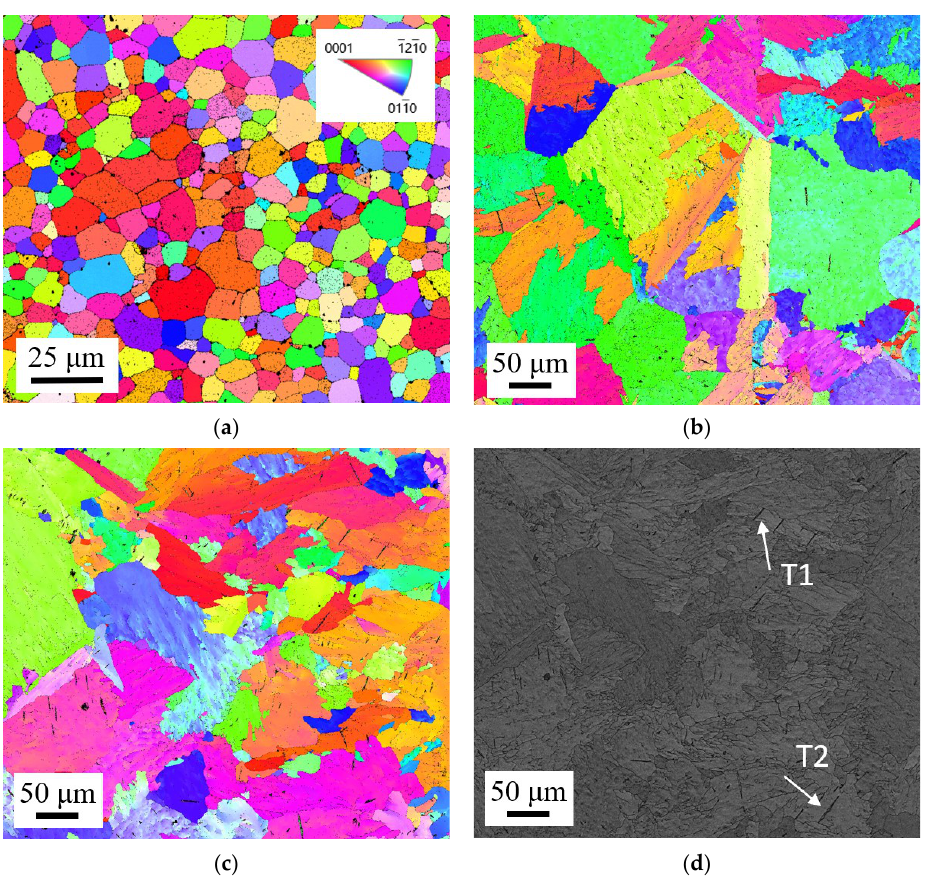
Figure 9. EBSD analysis of material specimens extracted from LMD tailored material: ( a ) IPF map for A-R specimen with no LMD thickening ( b ) IPF map of 0.3 mm LMD layer; ( c ) IPF map of 0.9 mm LMD layer; ( d ) Band contrast image of 0.9 mm LMD layer showing twinning. A high magnification coloured IPF map was performed to examine the microstructure of the LMD part in greater detail, Figure 10a. The map contains several single grains and a fragmented large grain with intragranular misorientations. The single grains are presumed to be the microstructure of the melted deposit material. The fragmented grain has an internal substructure containing partially and fully enclosed grains with low angle grain boundaries (LAGB) represented by blue lines, and several fully enclosed grains with high angle grain boundaries (HAGB) with misorientation over 15°, represented by black lines. The substructure has a single crystal orientation as determined by the IPF colouring. A misorientation angle measurement across a fully enclosed HAB grain, labelled L1 in HAGBs evolved from LAGBs with the accumulation of dislocations. An incomplete LAGB